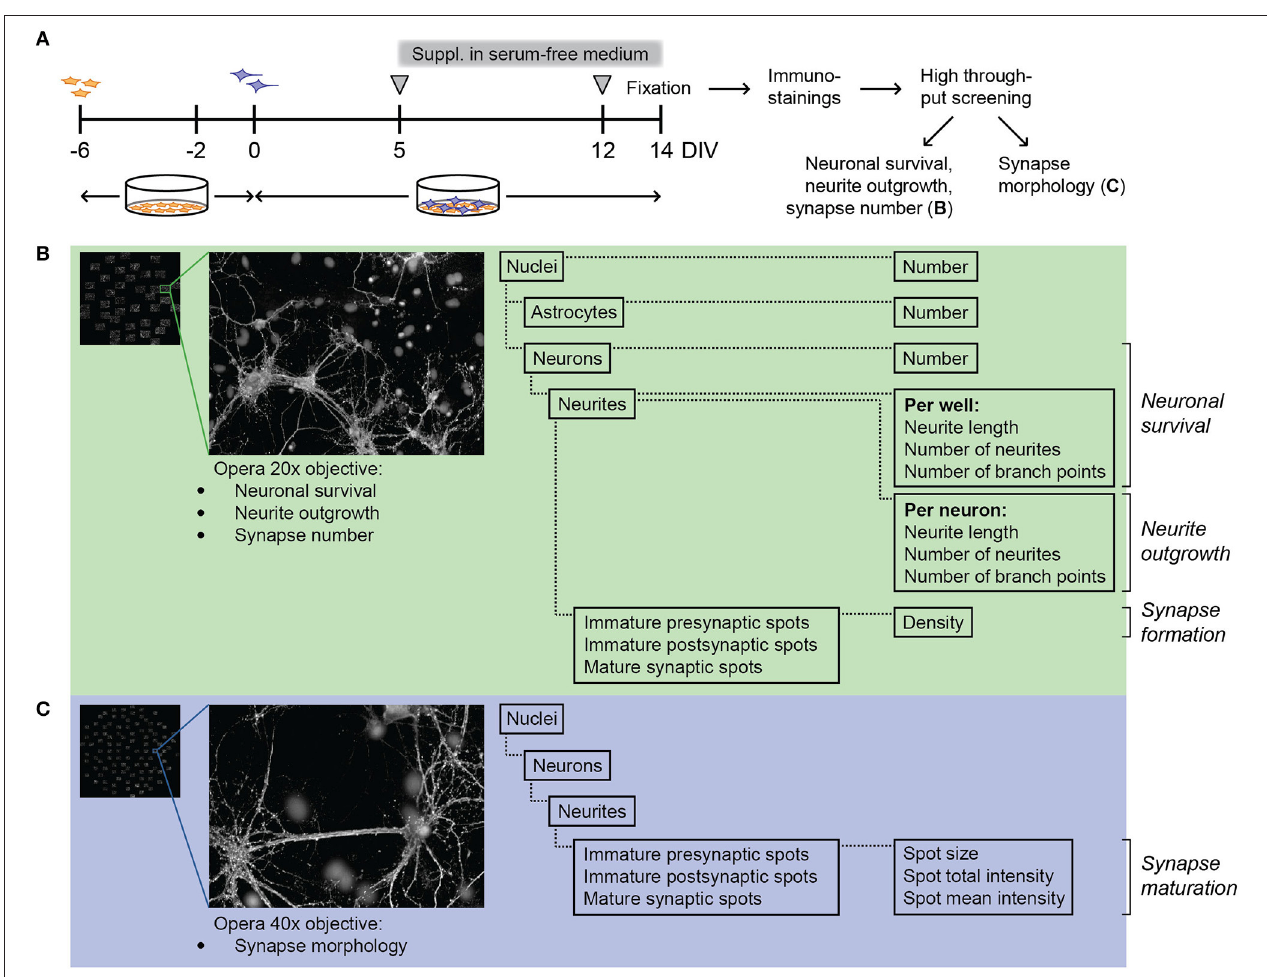
FIGURE 1 | Experimental design of neuron-astrocyte co-cultures and high content screening. (A) Time line of culturing and supplementation of FC or solvents to neuron-astrocyte co-culture. Freshly isolated P1 mouse astrocytes (in orange) were plated and cultured in DMEM. After 4 days (DIV-2), DMEM was replaced by neurobasal medium with B27 (NBM + B27). Two days later (DIV0), half of the NBM + B27 was replaced by fresh NBM + B27 containing E18 rat hippocampal neurons (purple). After 5 days in vitro (DIV5), NBM + B27 was removed, cells were washed and serum free medium (NBM + N2) with or without FC or solvents was added. At DIV12, half of the medium was replaced by fresh serum-free medium with or without FC or solvents. Cells were fixed at DIV14, stained for nuclei, neurites, pre- and post-synaptic spots followed by Opera High Content Screening (HCS) to analyze cell survival, neurite morphology and synapse number (explained in more detail in B ) as well as synapse morphology (explained in more detail in C ). (B) Left: overview image showing 40 fields of one well taken by HCS with 20x objective. Close-up: example image of one imaged field. Columbus software was used to analyze cell number, neurite morphology and number of immature presynaptic spots, immature postsynaptic spots and mature synaptic spots. (C) Left: overview image showing 100 fields of one well taken by HCS with 40x objective. Close-up: example image of one imaged field. Columbus software was used to analyze spot size and intensity as a measure of synapse